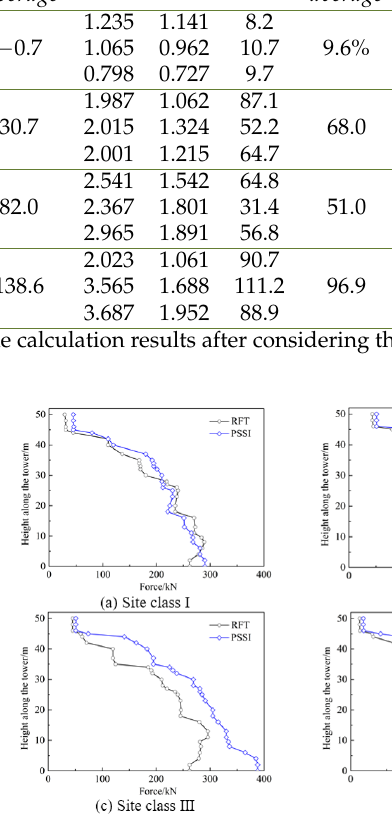
Fig. 10. Envelope value of displacement ratio under different site conditions.